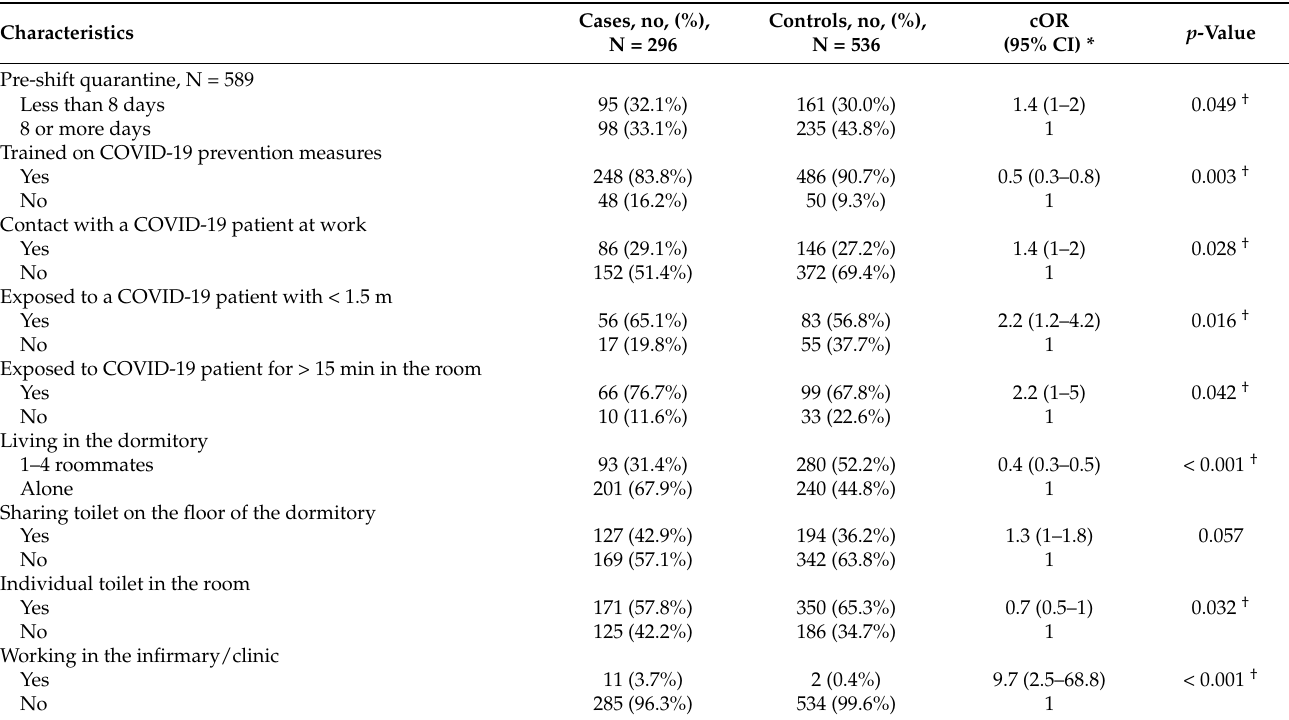
Table 3. Bivariate model of the environmental factors associated with the novel coronavirus